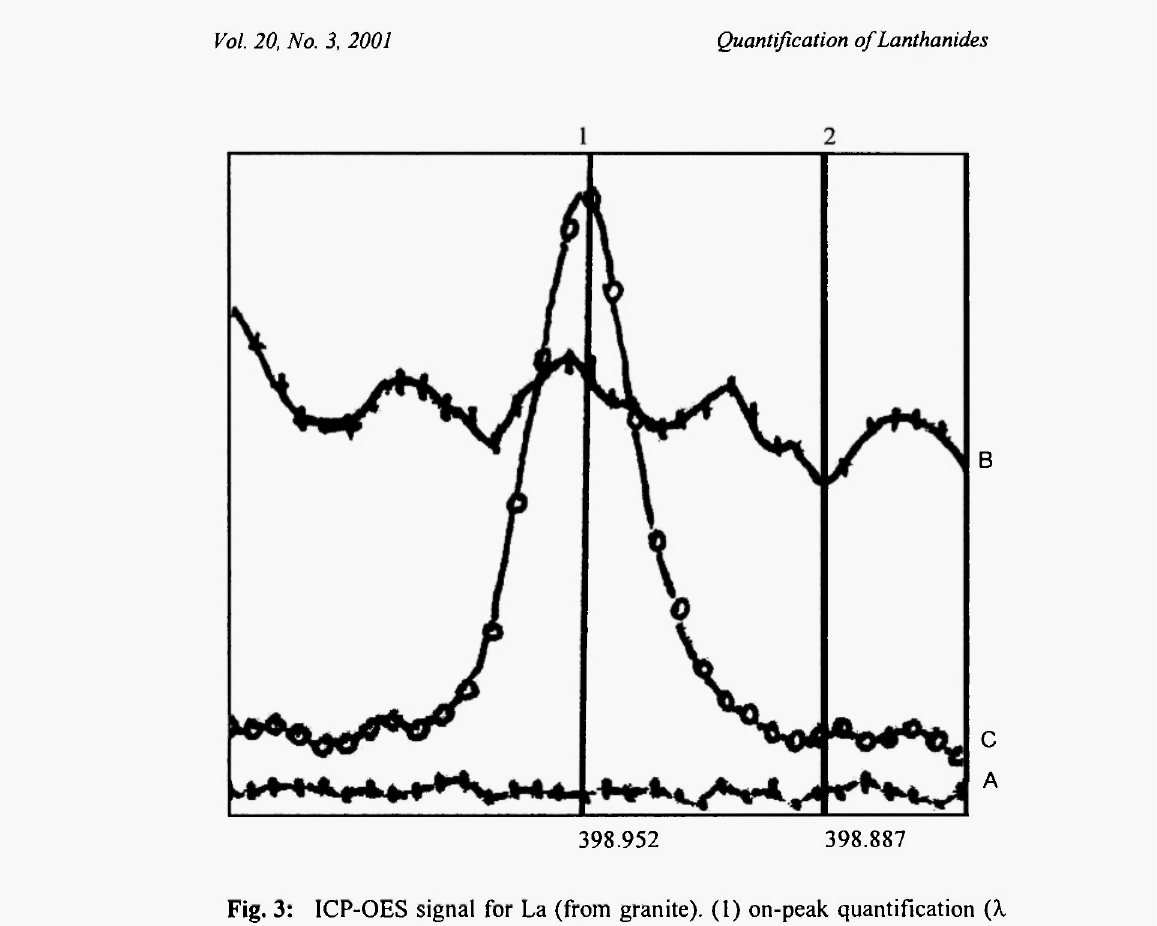
398.952 Fig. 3: ICP-OES signal for La (from granite). (1) on-peak quantification (λ = 398.952 nm), (2) background position (λ = 398.887 nm). A: deionized water, B: rock digest, C: interference-free La-signal after clean-up and preconcentration step.